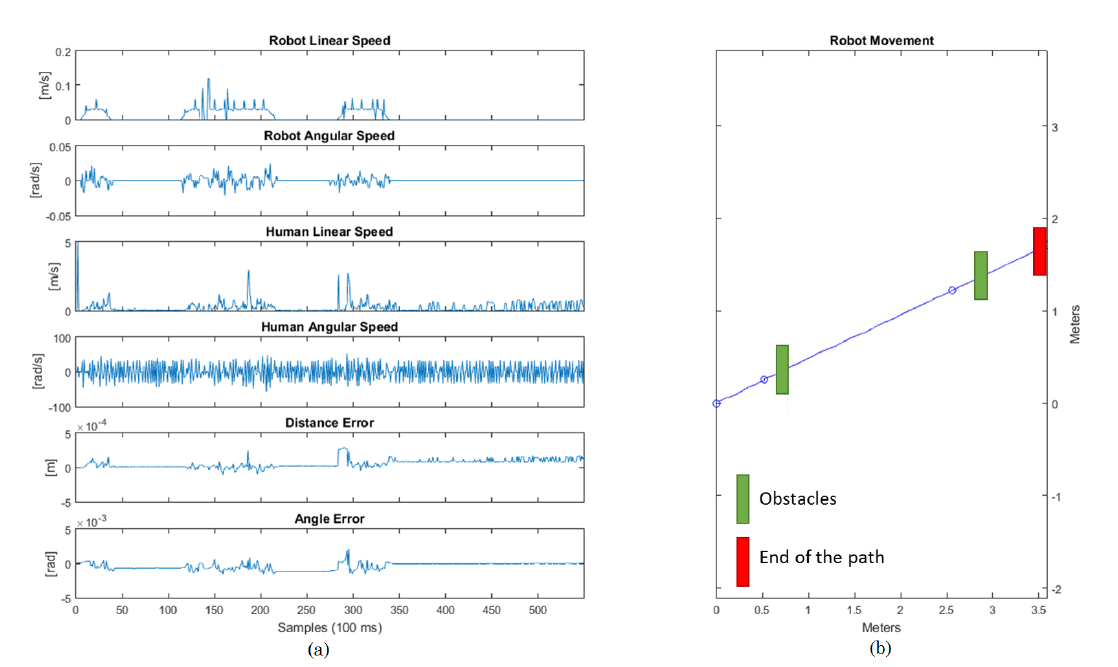
Figure 21. Results for the straight path with obstacles. ( a ) Graphical data about the experiment; ( b ) Graphical path of the experiment, showing the obstacles and the end of the path.